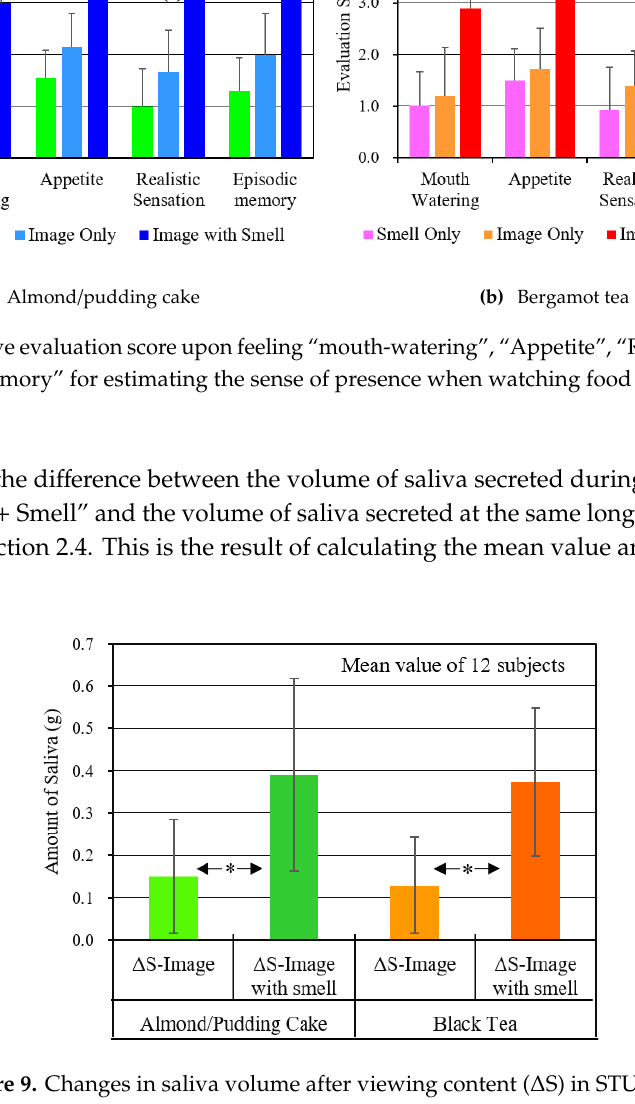
Figure 9. Changes in saliva volume after viewing content (ΔS) in STUDY 2.